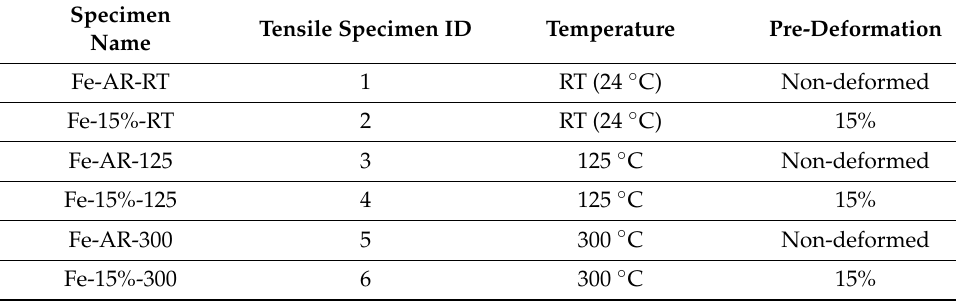
Table 2. Samples for nanoindentation and AFM from tensile specimens.